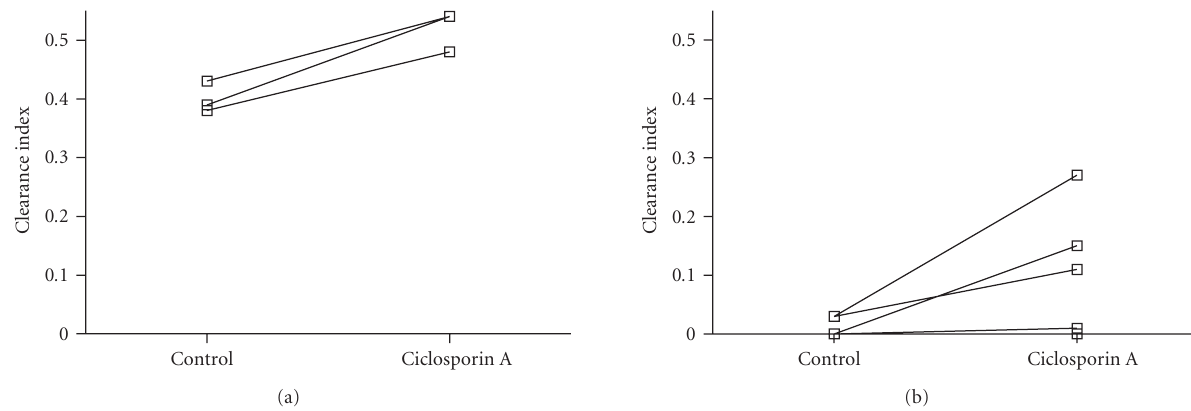
Figure 2: Variation of clearance index of lopinavir in the control and ciclosporin A phases (mean of values at 25, 30, 35, and 40 minutes versus 75, 80, 85, and 90 minutes) at low ((a), 10g/L) and physiologic ((b), 30, and 40 g/L) albumin concentrations. The lines join the data from the same placenta ( n = 3 at 10g/L, n = 3 at 30 g/L and n = 5 at 40 g/L). Mean clearance index of lopinavir (0 . 401 ± 0 . 058) with ciclosporin A (0 . 521 ± 0 . 066) at 10 g/L (95% CI of the di ff erence [ − 0 . 186, − 0 . 054], P = . 016) and 30 and 40 g/L (0 . 007 ± 0 . 027 versus